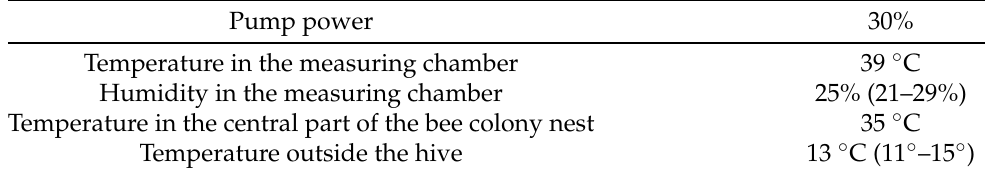
Table 3. The measurement parameters.